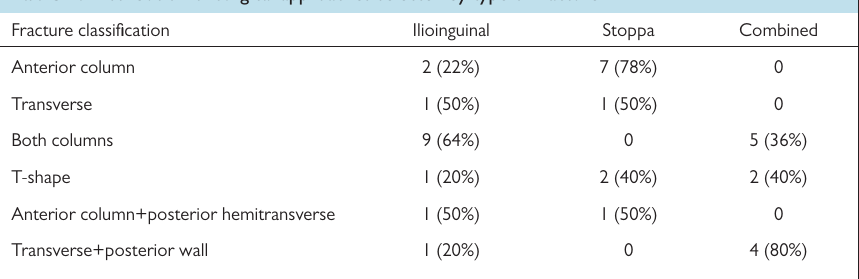
Table 2. Distribution of surgical approaches selected by type of fracture Fracture